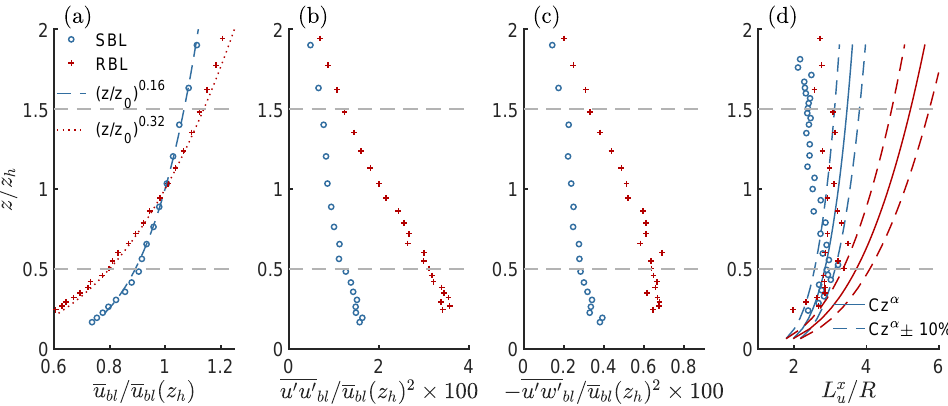
Figure 2. ( a ) Mean axial velocity u bl , ( b ) axial Reynolds stress component u (cid:48) u (cid:48) bl , ( c ) shear stress u (cid:48) w (cid:48) bl and ( d ) longitudinal integral length scale L x u within the turbulent boundary layer. All quantities are normalised by the mean velocity at hub height u bl ( z hub ) and the rotor radius R . The rotor edges are indicated by horizontal dashed lines and the legend denotes the flow conditions.